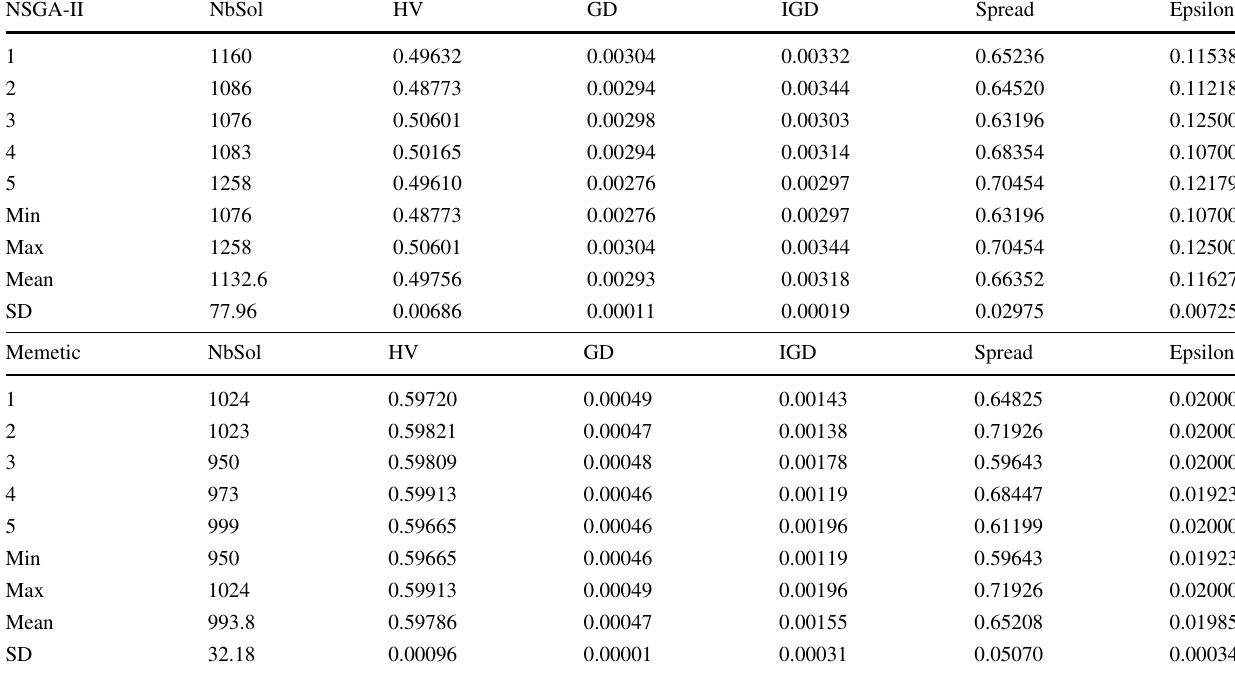
Table 6 Results for 5 runs of NSGA-II and memetic algorithms after two minutes and 30 seconds of running time